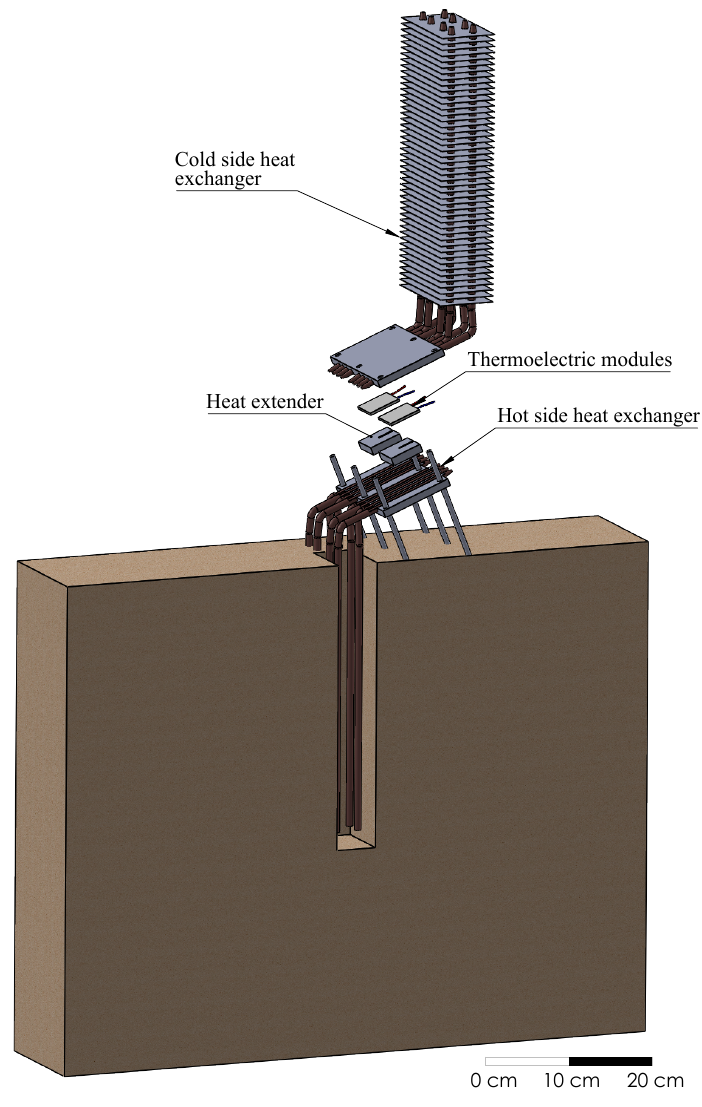
Figure 1. Exploded view of the geothermal thermoelectric generator installed at Teide